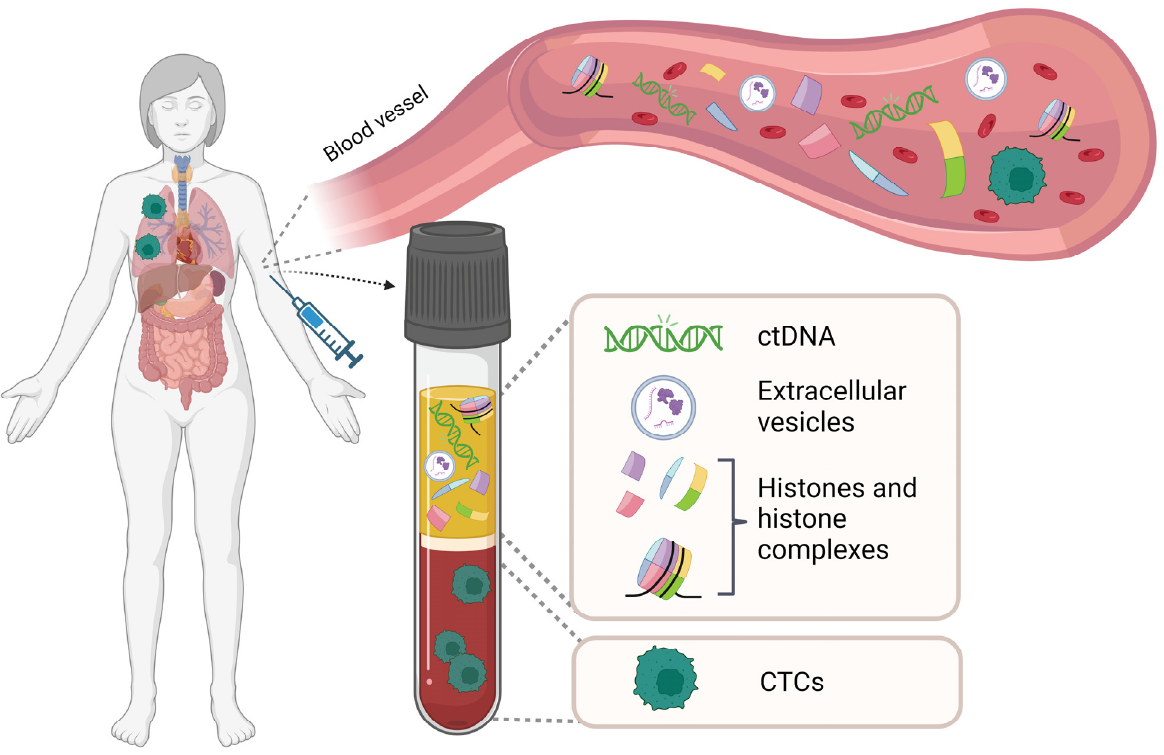
Figure 1. Schematic illustration of the components in a liquid biopsy. Liquid biopsy obtained from peripheral blood contains different tumor-associated materials such as circulating tumor cells (CTCs), circulating tumor DNA (cfDNA), extracellular vesicles (EVs), free histones, and histone complexes. Such fractions can be isolated and analyzed for tumor-specific aberrations at the genomic, transcriptomic, proteomic, and metabolomic levels. Figure created with BioRender.com.